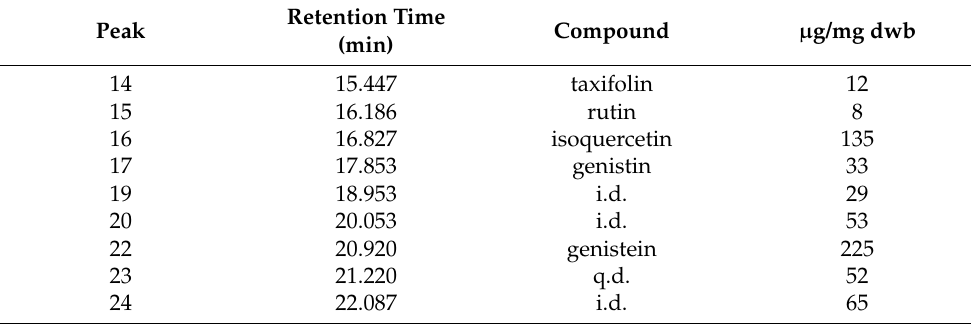
Table 1. Phenolic composition of the P. tridentatum extract.